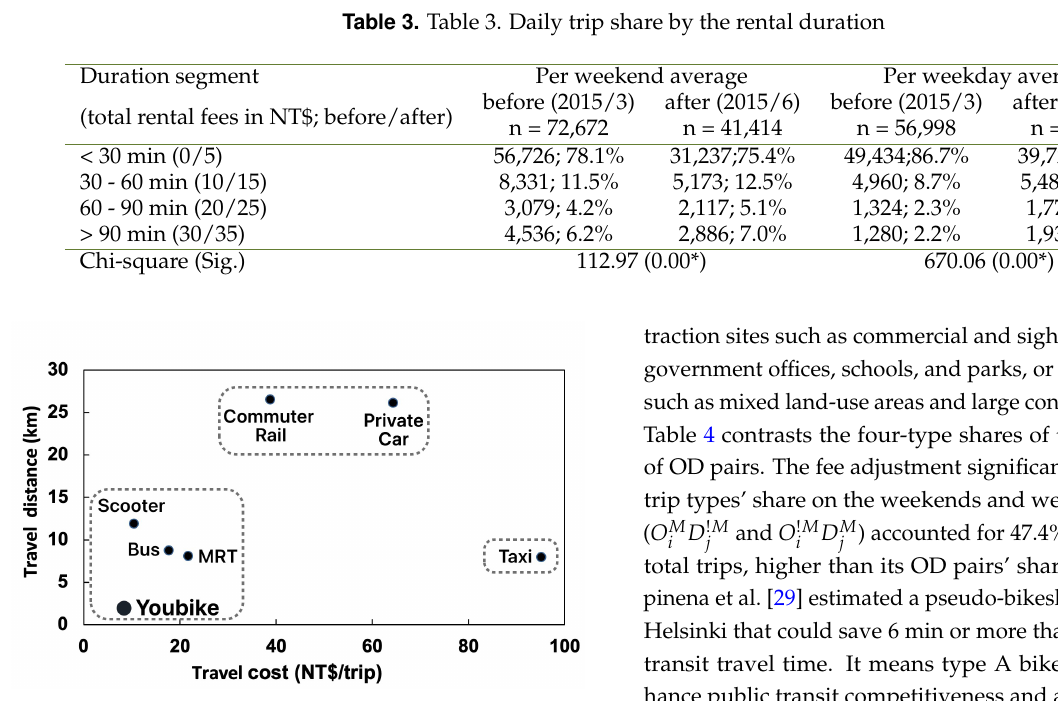
Fig. 3. Average travel cost and distance of modes in Taipei Note: Private vehicle travel costs include gas and parking fees